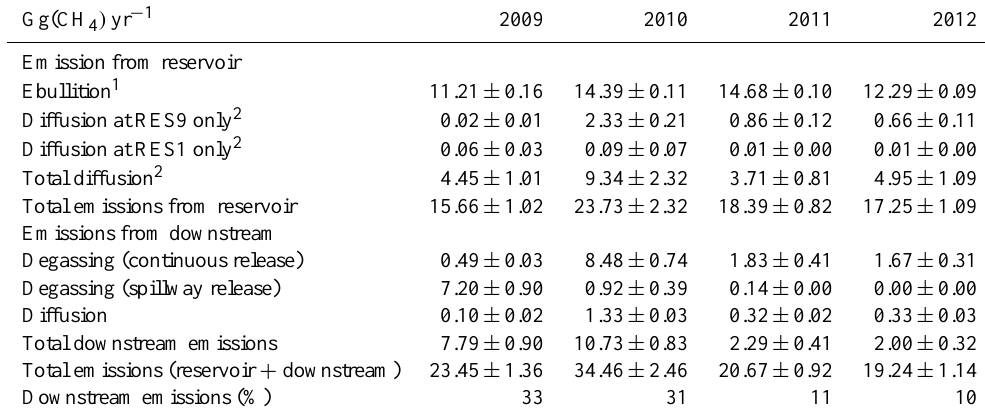
Table 2. Methane emissions from the Nam Theun 2 Reservoir between 2009 and